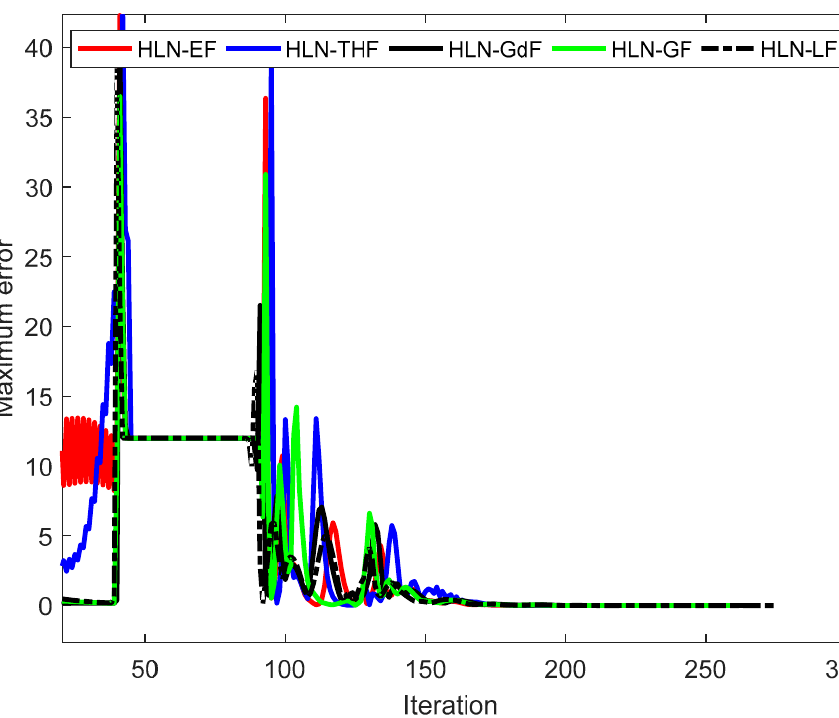
Figure 12. Maximum error vs. iteration for the second system with the second model of payment.